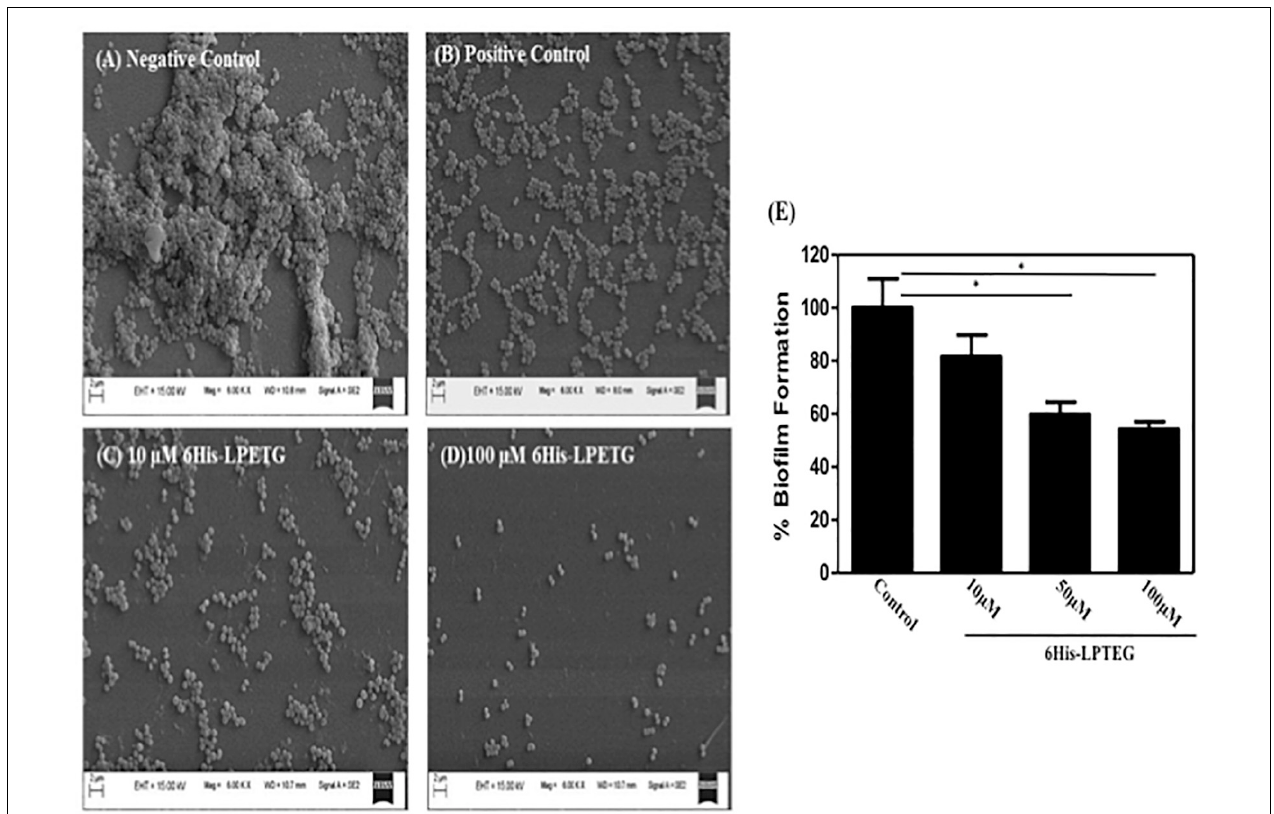
FIGURE 3 | Representative SEM image of S. aureus biofilm formation using different concentrations of synthetic peptide. Images were acquired at 6000X magnification, (A) Negative Control (B) 100 µ M Transchalcone used as positive control, 6His-LPETG peptide at (C) 10 µ M and (D) 100 µ M. (E) Biofilm formation by S. aureus as assayed by crystal violet, growing on silicone coated latex catheter disks in the presence of 6His-LPETG. Experiment was done is triplicates and P < 0.05 was considered as significant. Error bars are mean ± SEM. * p <